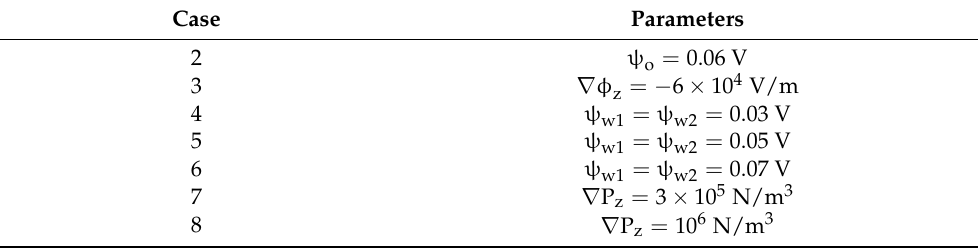
Table 3. Parameters that are different from the reference case. Two-parallel-plate channel composed of two porous